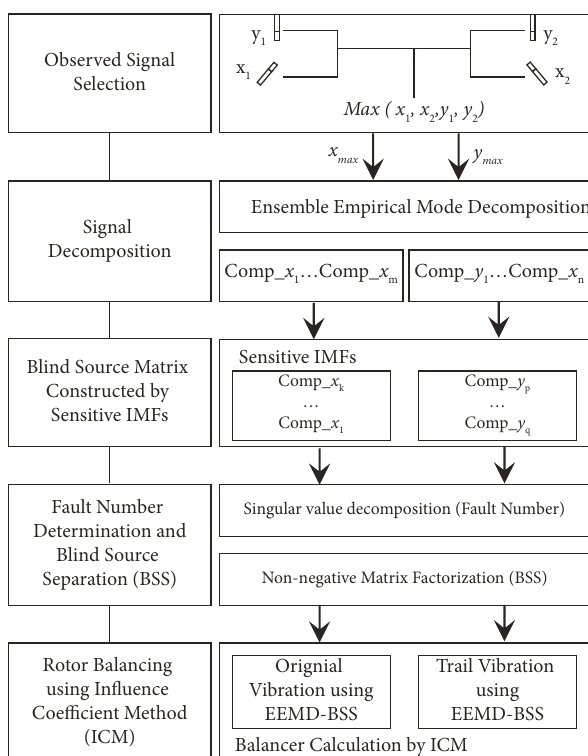
Figure 2: The framework of